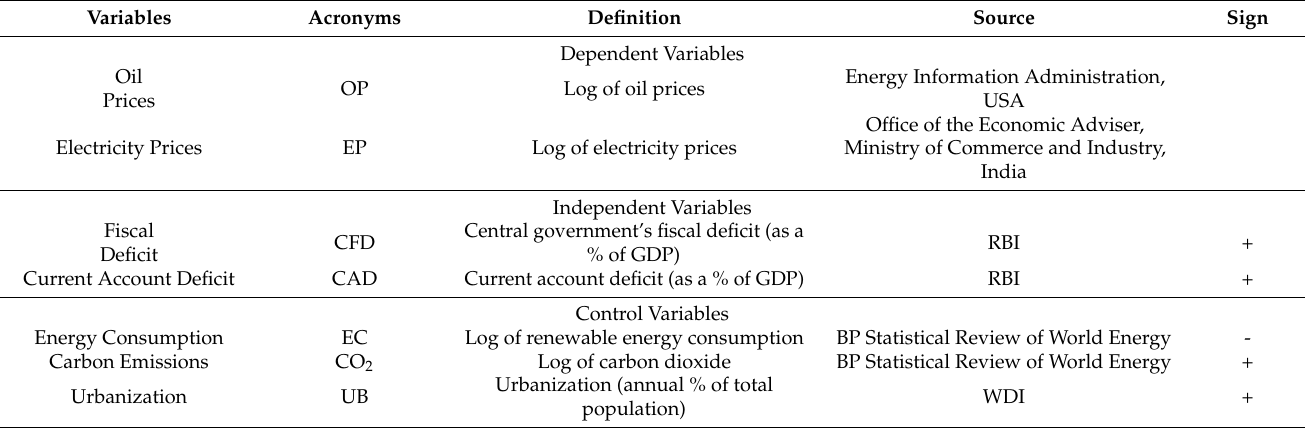
Table 1. Description of the variables.